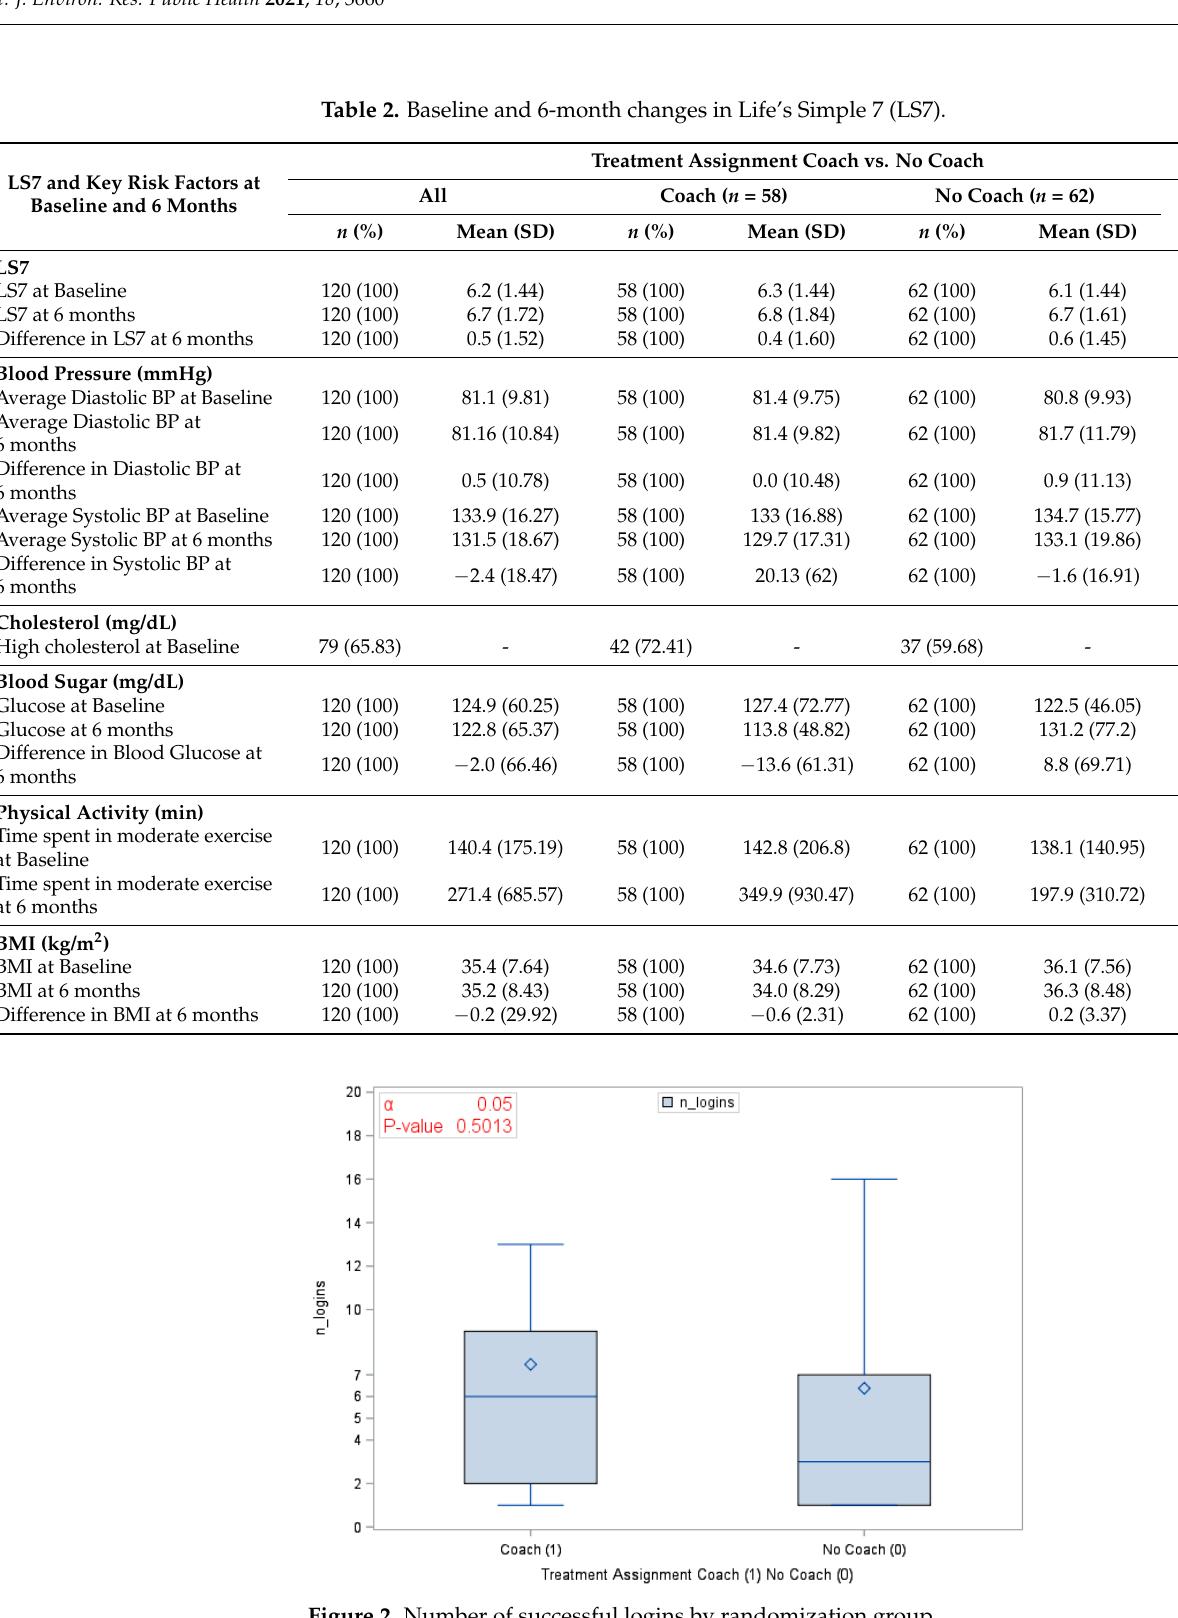
Figure 2. Number of successful logins by randomization group.